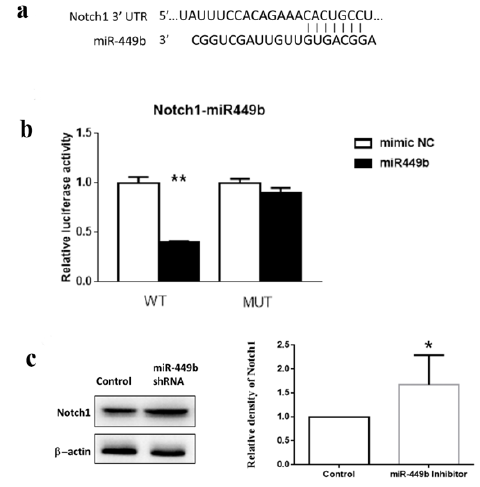
Figure 8. miR-449b targeted Notch1 and modulated the Notch1 level in cells. ( a , b ) H293T cells were co-transfected with either miR-449b mimic or scrambled control miRNA and a luciferase construct containing the Notch1-UTR (wild-type or mutant). After 48 h, cells were collected, and the dual luciferase assay was performed. ** p < 0.01 vs. negative control. ( c ) Western blot detection of Notch1 expression in NE-4C and showing the semi-quantitative results of protein expression in bar graph. N = 6 per group. * p < 0.05.